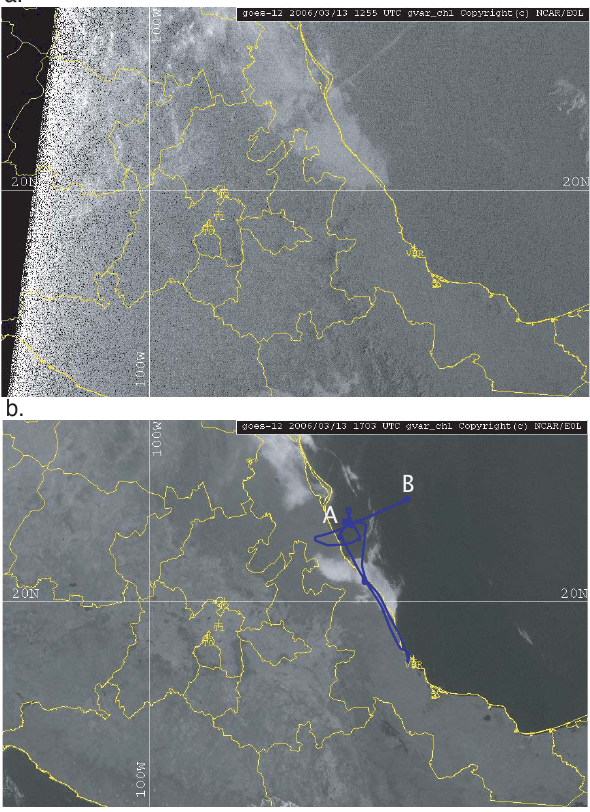
Fig. 1. (a) : Fractional absorption for the 6 March case. (b) : Per- centage change in fractional absorption for a 10% increase in gas amounts.